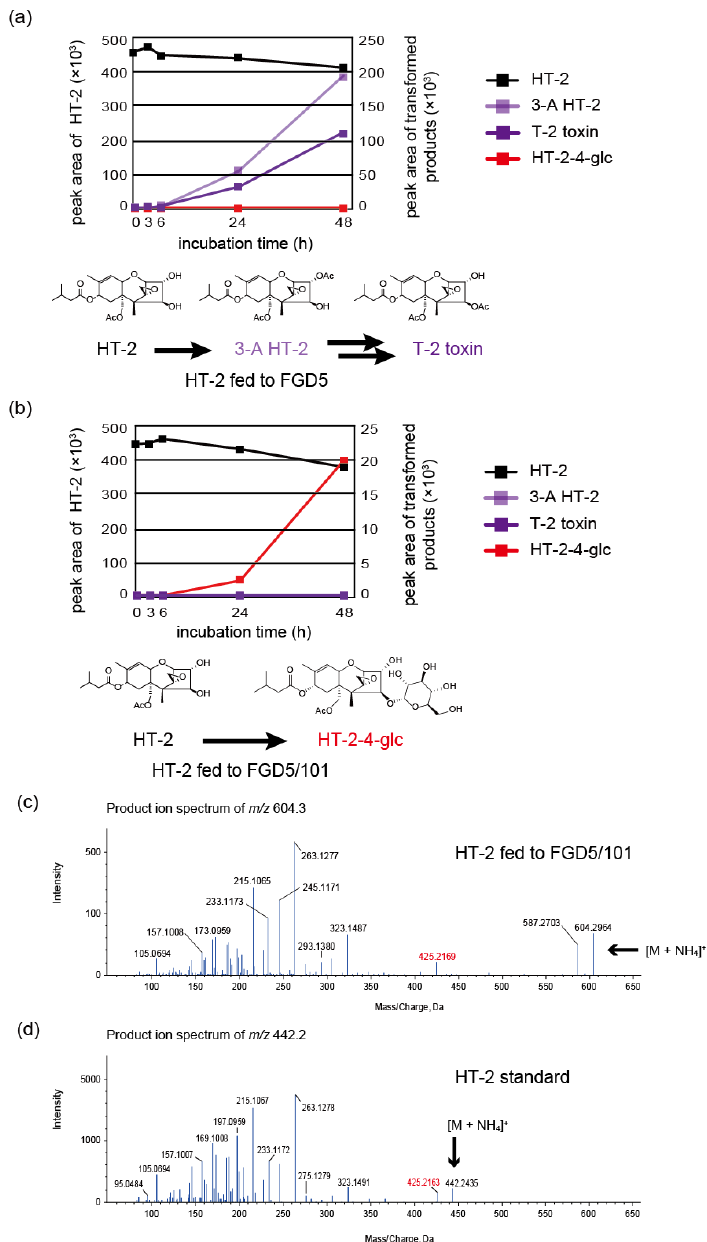
Figure 4. Metabolism of HT-2 toxin (HT-2) fed to the Fusarium. graminearum mutants, with or without functional Tri101 . The fresh mycelia of FGD5 and FGD5/101 in rice flour (RF) liquid medium were fed with 20 µg/mL of HT-2 and cultured with gyratory shaking at 125 rpm and 25 °C. The culture was sampled at the indicated time and aliquots were used to monitor the changes in quantity. The metabolites of HT-2 were analyzed by the extracted ion chromatogram (XIC) mode in LC-MS/MS. ( a ) Time course changes of HT-2 and its transformed products fed to the FGD5 mutant. The values at the left and right perpendicular axes represent the peak area of the substrate HT-2 and possible products to be assessed [T-2 toxin, 3-acetyl HT-2 toxin (3-A HT-2), and HT-2 toxin-4- O - α -glucopyranoside (HT-2-4-glc)], respectively. ( b ) Time course changes of HT-2 and its transformed products fed to the FGD5/101 mutant. The values at the left and right perpendicular axes represent the peak area of the substrate HT-2 and possible products to be assessed (T-2 toxin, 3-A HT-2, and HT-2-4-glc), respectively. ( c ) The MS/MS spectrum of [HT-2-4-glc + NH 4 ] + detected in the feeding sample of the FGD5/101 mutant at 48 h. ( d ) The spectrum of [HT-2 + NH 4 ] + in our in-house MS/MS library is shown for